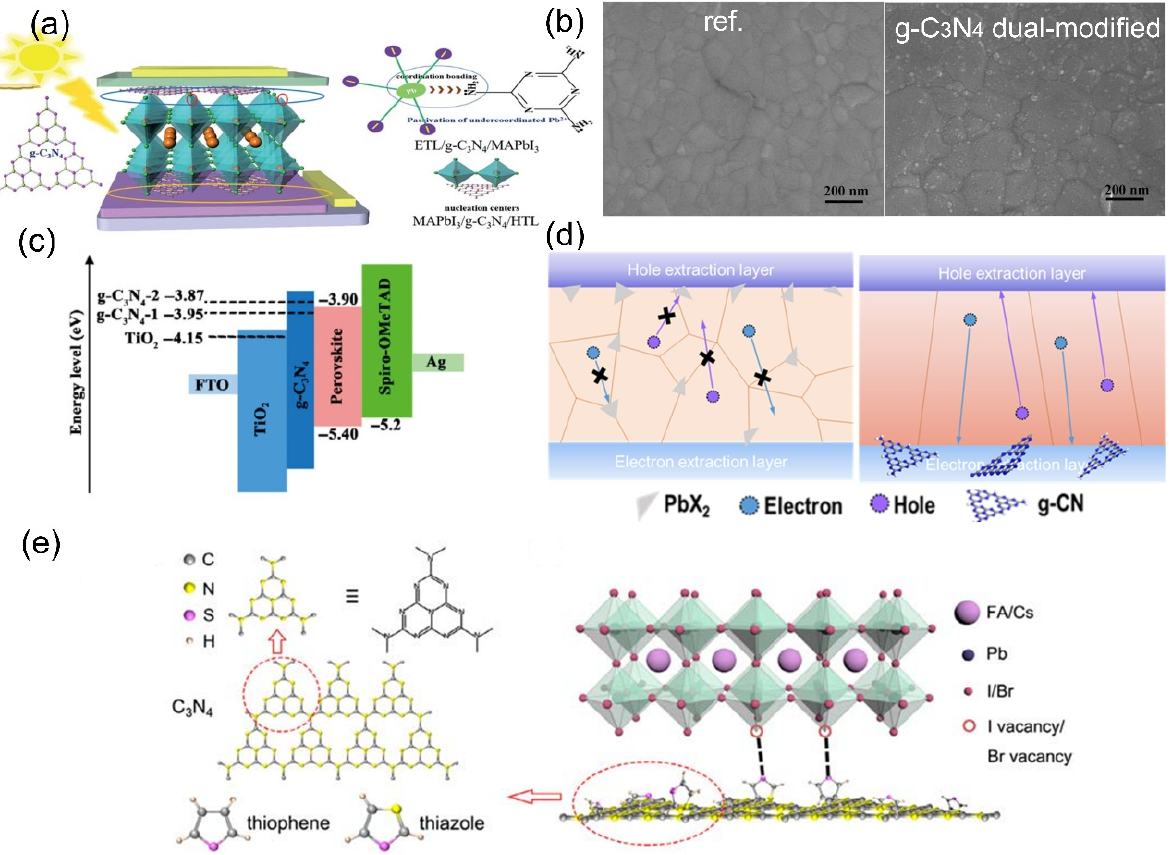
Figure 5. ( a ) Schematic diagram of g–C 3 N 4 dual–modified PSCs. ( b ) SEM of perovskite films (reproduced with permission [95]; copyright 2018, Royal Society of Chemistry). ( c ) Energy band alignment of the device. The E F level of the ETL, without and with g – C 3 N 4 , are represented with a dotted line (reproduced with permission [98]; copyright 2021, Springer Nature). ( d ) Schematic of the vertical carrier transportation of the perovskite films via buried manipulation (reproduced with permission [99]; copyright 2021, John Wiley and Sons). ( e ) Schematic illustration of the possible interface defect sites (reproduced with permission [100]; copyright 2021, John Wiley and Sons).